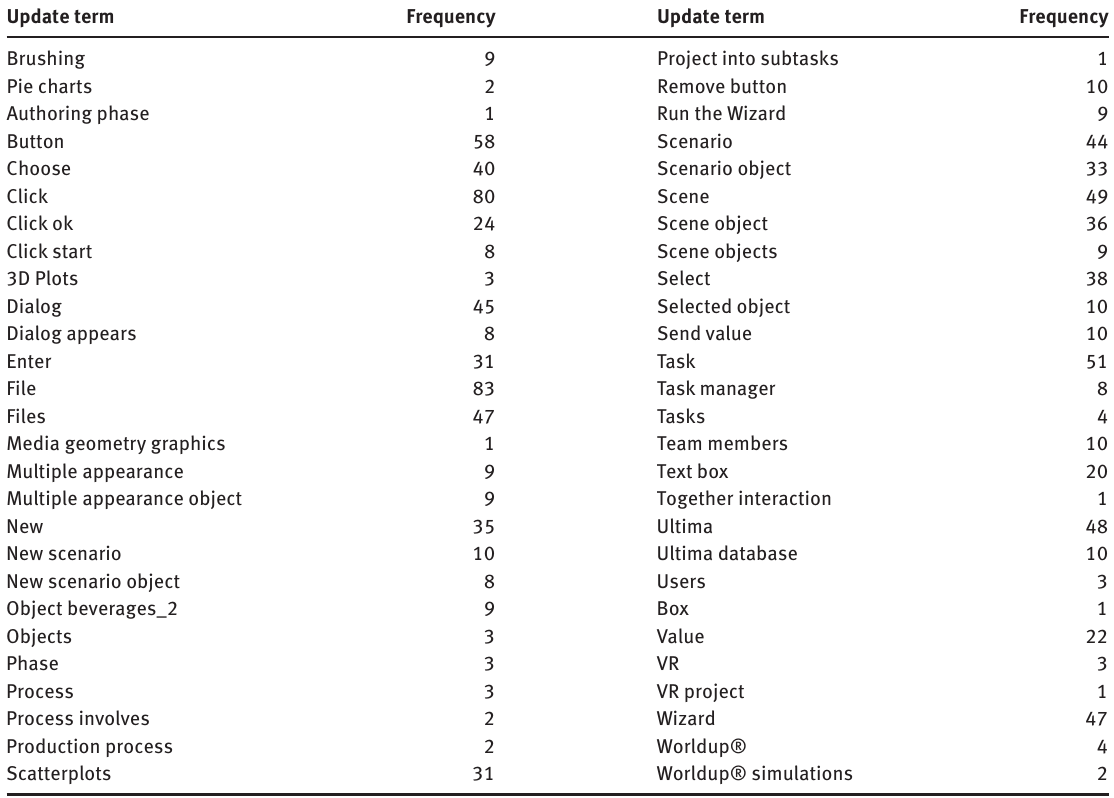
Table 1. A Sample List of Update Terms and Their Frequency.